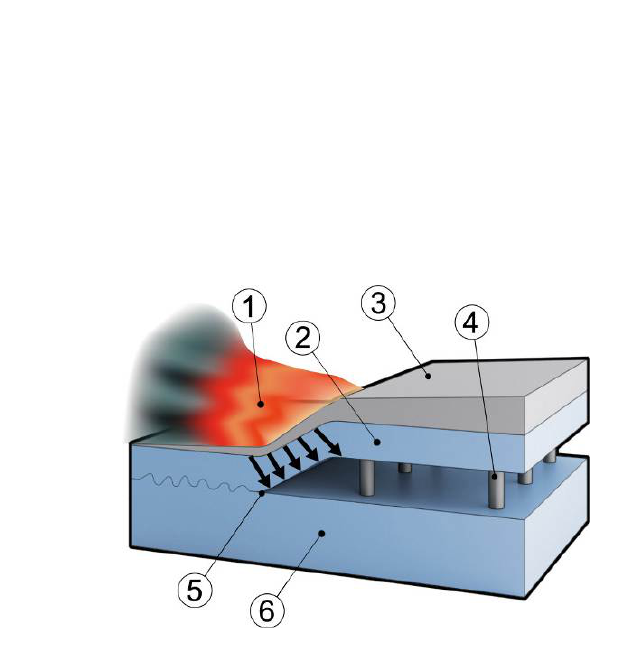
Figure 1 – Explosive welding scheme: 1 - Detonation products, 2 - coating for base material, 3 - explosive, 4 - spacers, 5 - connection point, 6 - base material